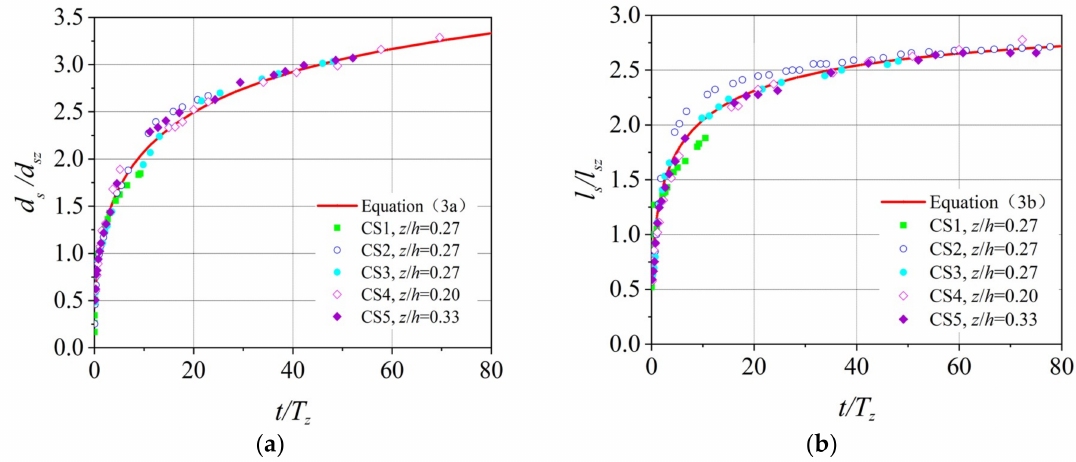
Figure 4. Temporal evolution of dimensionless scour depth ( a ) and scour length ( b